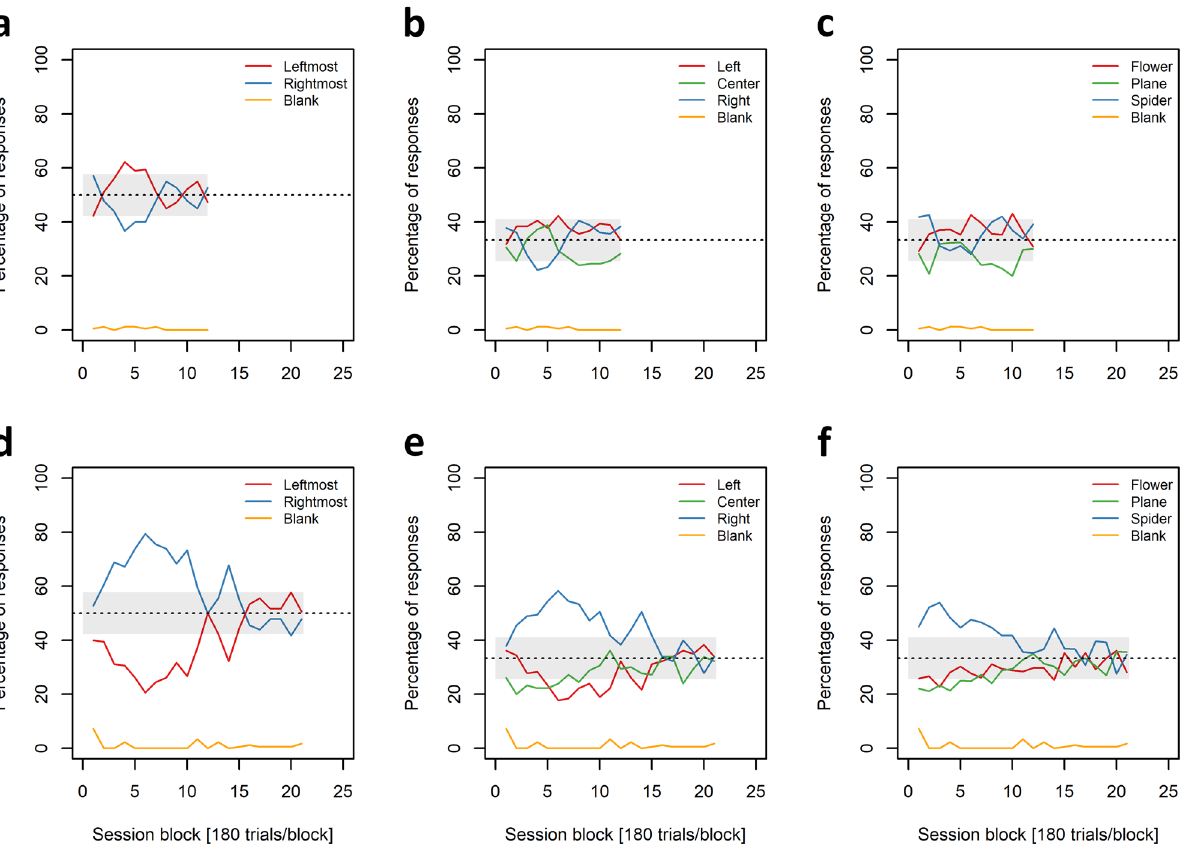
Figure 3. Exemplary response profiles of a young (SB 1 ; a – c ) and an old (HC 7 ; d – f ) individual. ( a – f ) Percentages are presented for session blocks of 5 sessions (180 trials). Dashed black lines represent the expected response probabilities for the presented instances, shaded grey areas include all responses for which the probability is > 5% (as based on two-tailed binomial tests: n = 180, alpha = 0.05). Session blocks in which this area was left were considered as biased for the represented instances. ( a , d ) Individual percentages of responses made to either the leftmost or the rightmost of the two simultaneously presented items (relative position). ( b , e ) Individual percentages of responses made to the stimulus presented in either the left RW, the centre RW, or the right RW (absolute RW location). ( c , f ) Individual percentages of responses made to either the flower, the plane, or the spider